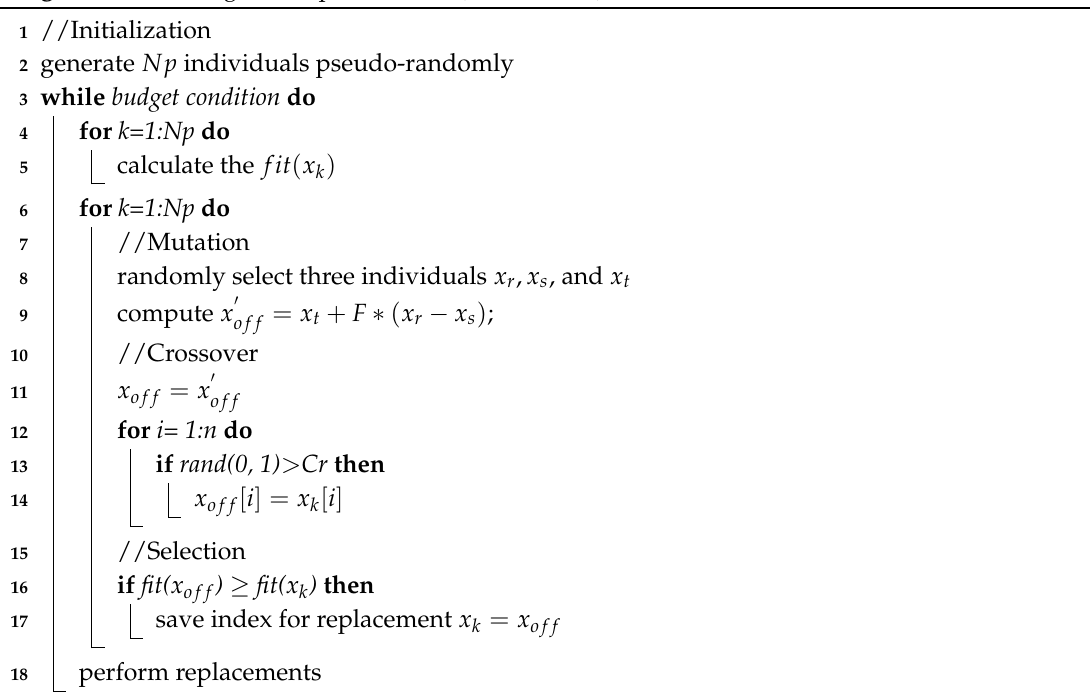
Algorithm 1: DE algorithm pseudocode